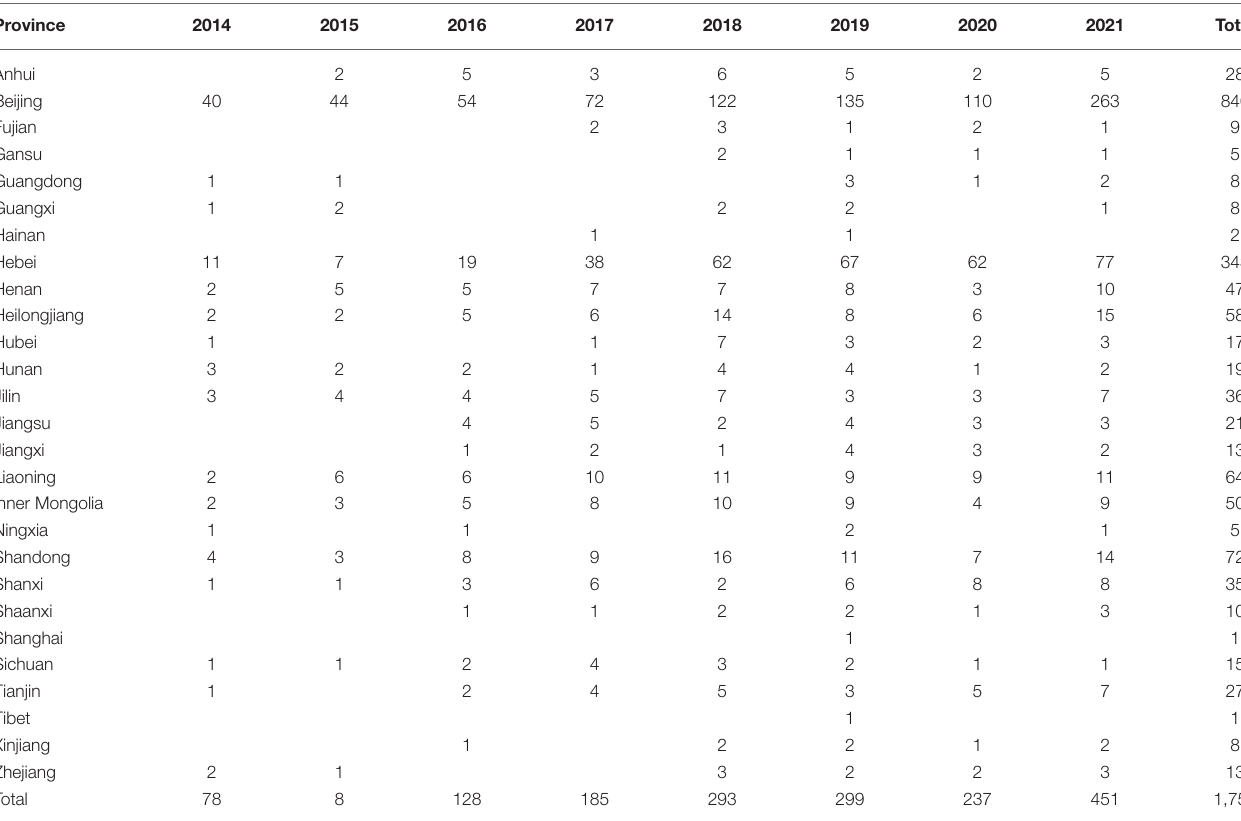
TABLE 3 | The distribution of clinical NTM strains throughout 27 provinces in China, 2014–2021. Province